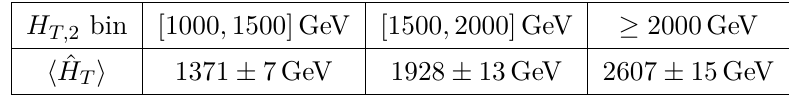
ˆ Table 2 . The average H T in each H T, 2 bin computed from the integrated cross section of d σ NNLO in each bin. The uncertainty indicated above is from MC